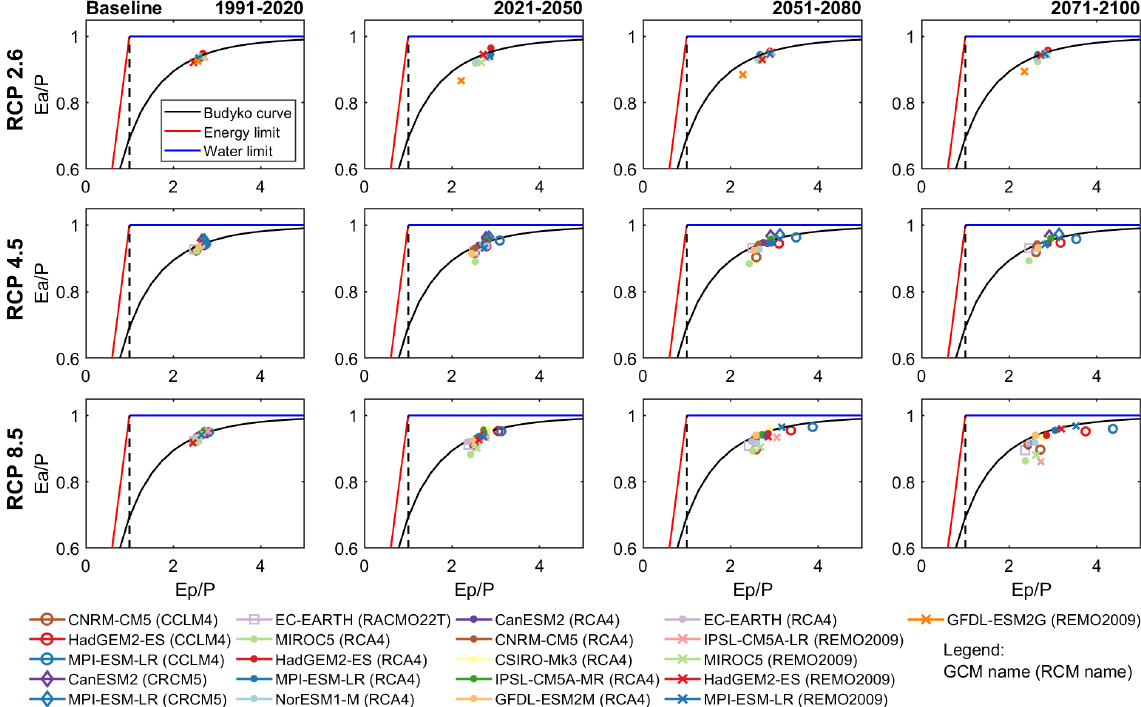
Figure 4. Plausibility of hydrological processes with the Budyko framework representing the evaporative index, i.e. the ratio of actual evaporation to rainfall ( E a /P ), as a function of the aridity index, i.e. ratio of potential evaporation to rainfall ( E p /P ). The black dashed line represents the limit where precipitation equals potential